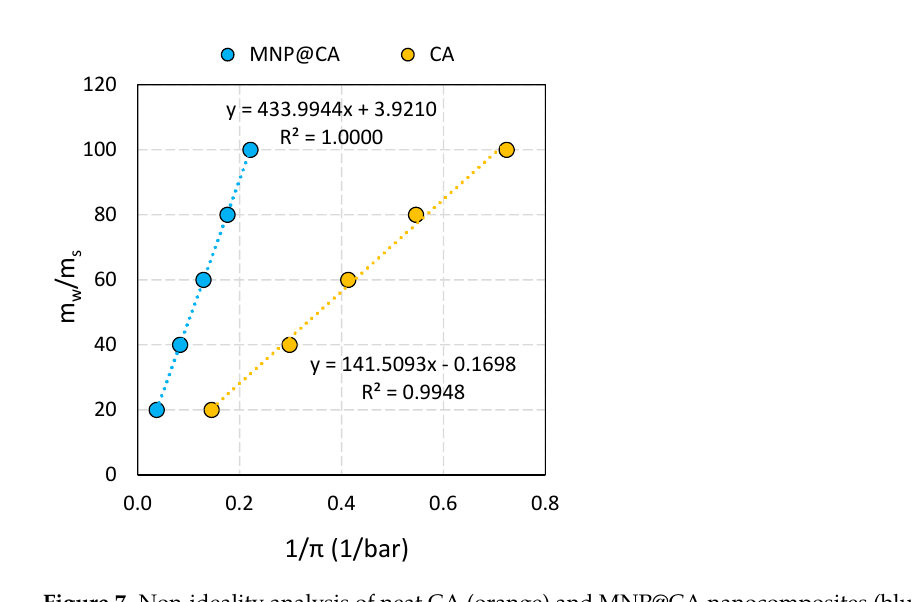
Figure 7. Non-ideality analysis of neat CA (orange) and MNP@CA nanocomposites (blue). m W and m S : mass of water and mass of solute, π : osmotic pressure. Dashed lines represent fits to Equation (8) (r > 0.995) and fitting parameters are given in Table 4. The fitting parameters of the non-ideality analysis Fe 3 O 4 @CA. S I